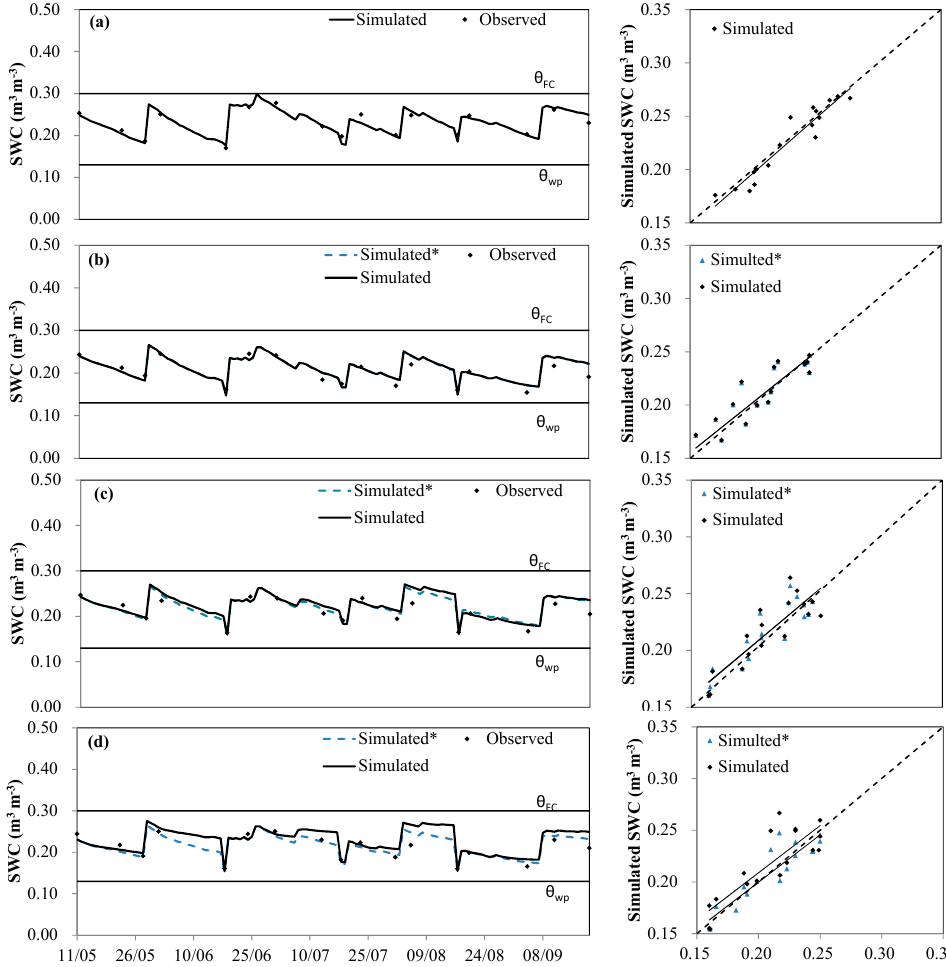
Figure 5. Simulated and observed soil water content ( SWC ) during the whole growth period of alfalfa in 2019: ( a ) W1S0, ( b ) W2S2, ( c ) W2S4 and ( d ) W2S6. The simulations with a constant yield response factor ( K y = 1.2) were shown by solid lines and dynamic K y by dotted lines. On the right panel, the corresponding regressions forced to the origin were shown, and simulations with recomputed K y were shown with the asterisk (*).